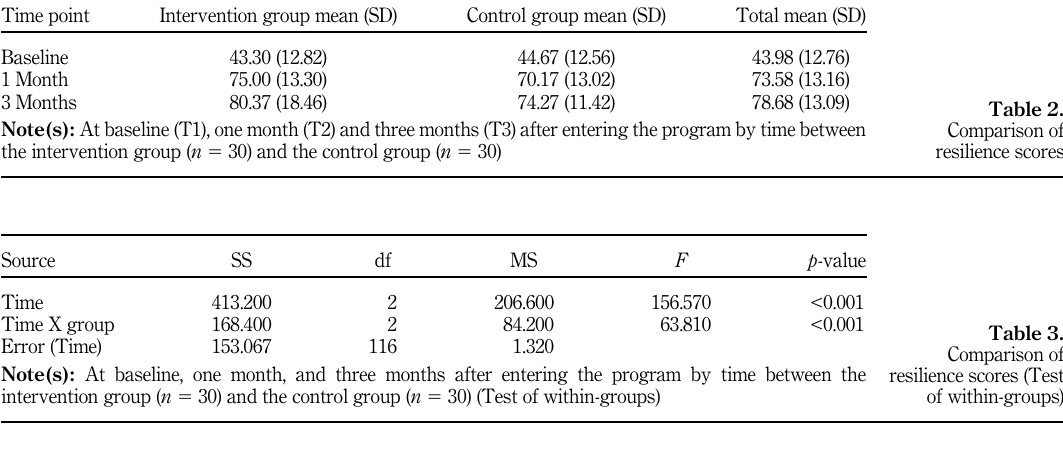
Figure 2. The mean scores of resilience between the intervention group